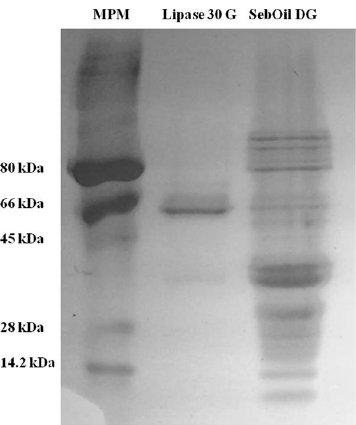
Figure 4. Molecular characteristics of the commercial enzymes (Lipase 30 G and SebOil DG) were determined by the electrophoretic technique.